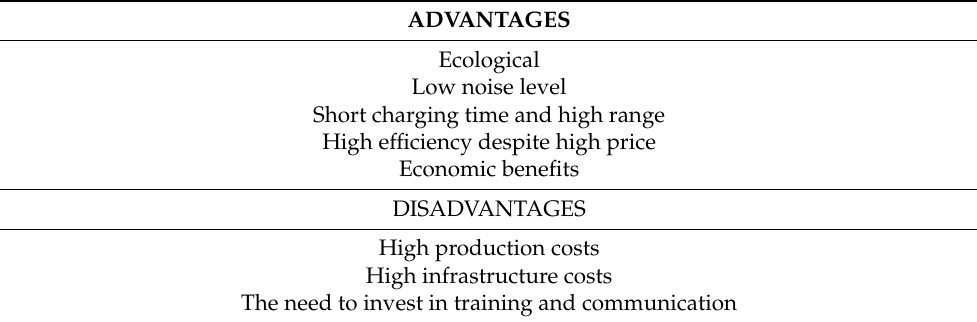
Table 10. Advantages and disadvantages of hydrogen propulsion in bus transport